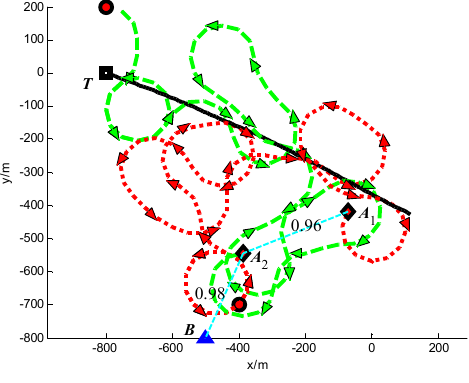
Figure 7. Trajectories of UAVs and target at t = 64 s (Group A in Scenario 1).